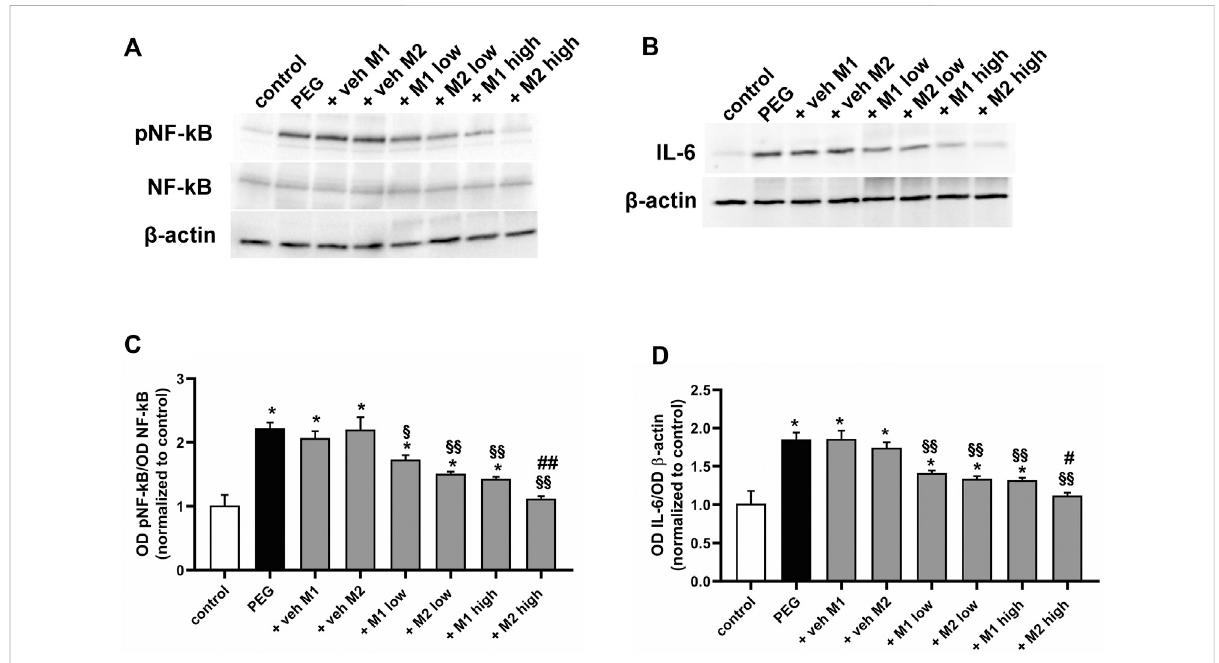
FIGURE 2 Effect of M1and M2on in fl ammatorymarkers.Representative Westernblots (A,B) and densitometricanalysisofpNF-kB/NF-kBratio (C) and IL- 6 (D) in controls, PEG-injected untreated, PEG-injected treated with M1 or M2 vehicles, PEG-injected treated with low or high dose of M1 as well as with low or high-dose of M2. β -actin was used as loading control. Data are plotted as mean ± SEM. Differences among groups were assessed using one-way ANOVA followed by Tukey ’ s multiple comparison post-hoc test (N = 6). * p < 0.001 vs. control; § p < 0.01 and §§ p < 0.001 vs. respective vehicle; # p < 0.05, ## p < 0.01 vs. M1